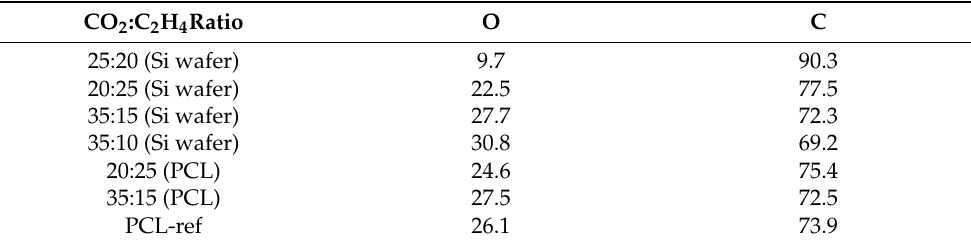
Table 1. Composition of samples (in at. %) derived from the XPS analysis.